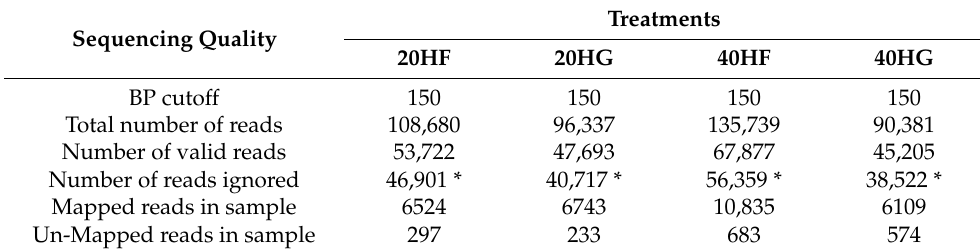
Table 5. Sequencing quality and mapped reads per